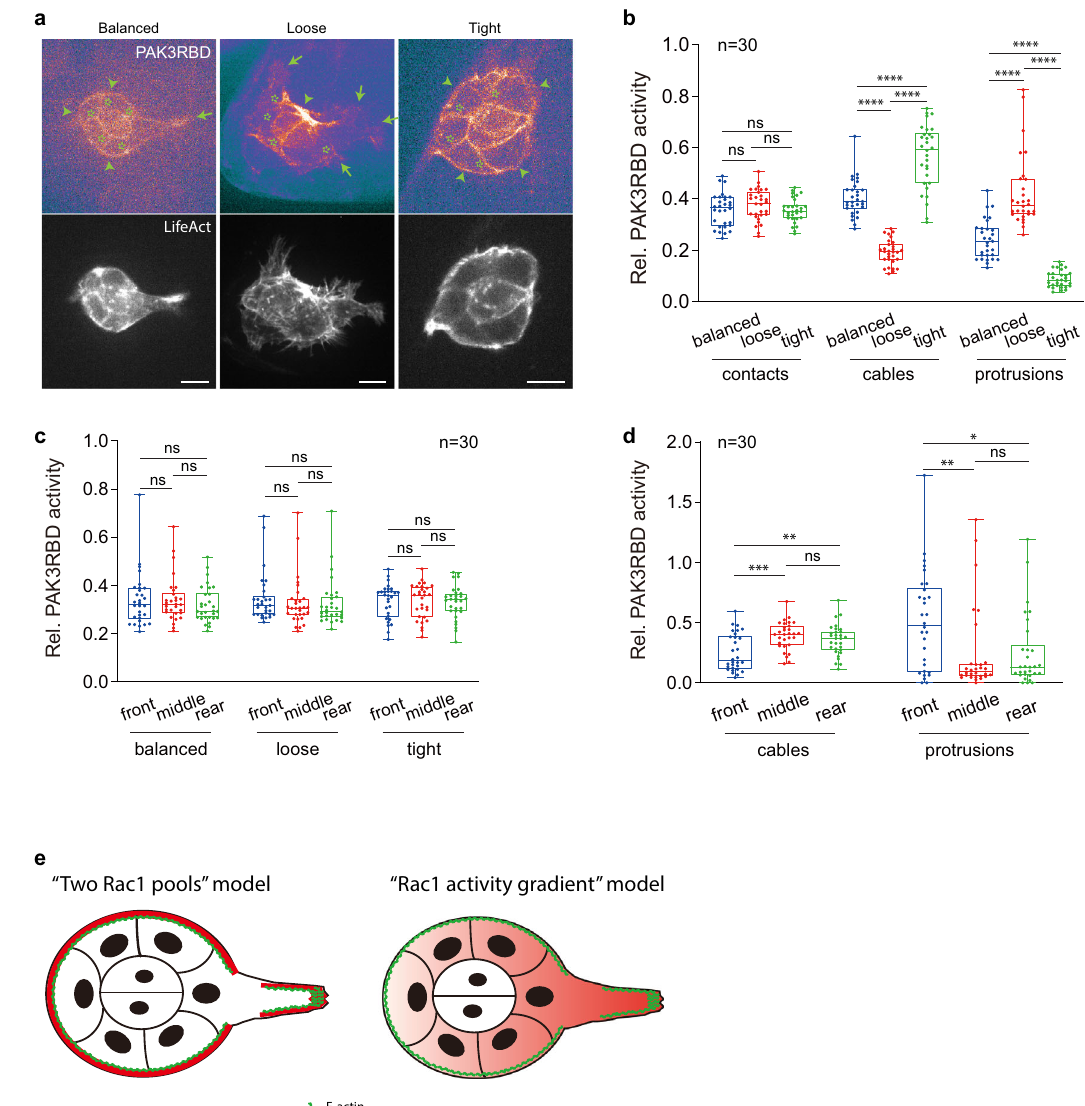
Fig.2|Rac1activitiesvarybetweenprotrusionsandcablesinmigratingborder cell groups. a Representative PAK3RBD-GFP and F-actinimages in balanced, loose or tight border cell groups expressing LifeAct-RFP to discriminate and label dif- ferent regions enriched with subcellular F-actin signals. Green arrows marking protrusions, green arrowheads marking cables, while green stars marking border cell-to-cell contacts. b Quanti fi cation of relative PAK3RBD-GFP intensity located at contacts, cables or protrusions in balanced, loose or tight border cell groups. c Quanti fi cation of relative intensity of total peripheral PAK3RBD-GFP signals dis- tributed at the front, middle or rear cells in balanced, loose or tight border cell